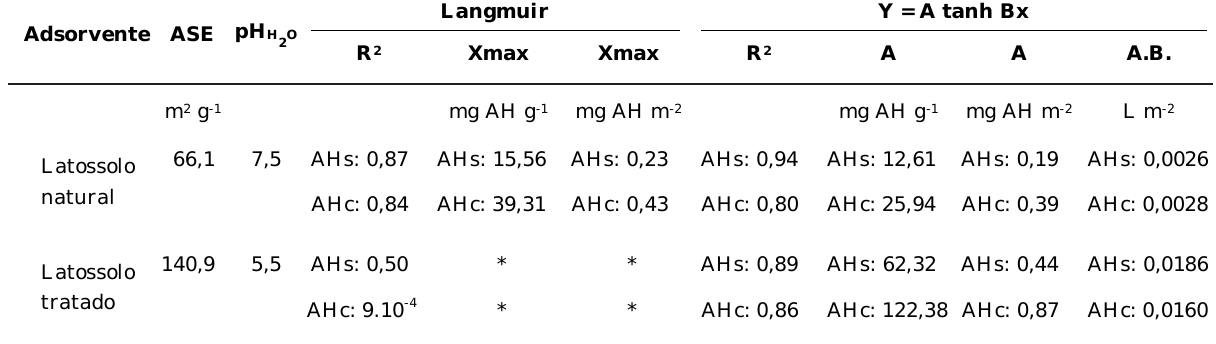
Quadro 3. Área superficial específica (ASE); pH em H adsorção máxima, Xmax (por peso e por área de adsorvente) para o modelo linearizado de Langmuir; coeficiente de determinação (R 2 ), adsorção máxima, A (por peso e por área de adsorvente), e produto A.B segundo a equação y = A tanh Bx; para Latossolo Roxo natural e Latossolo Roxo tratado com